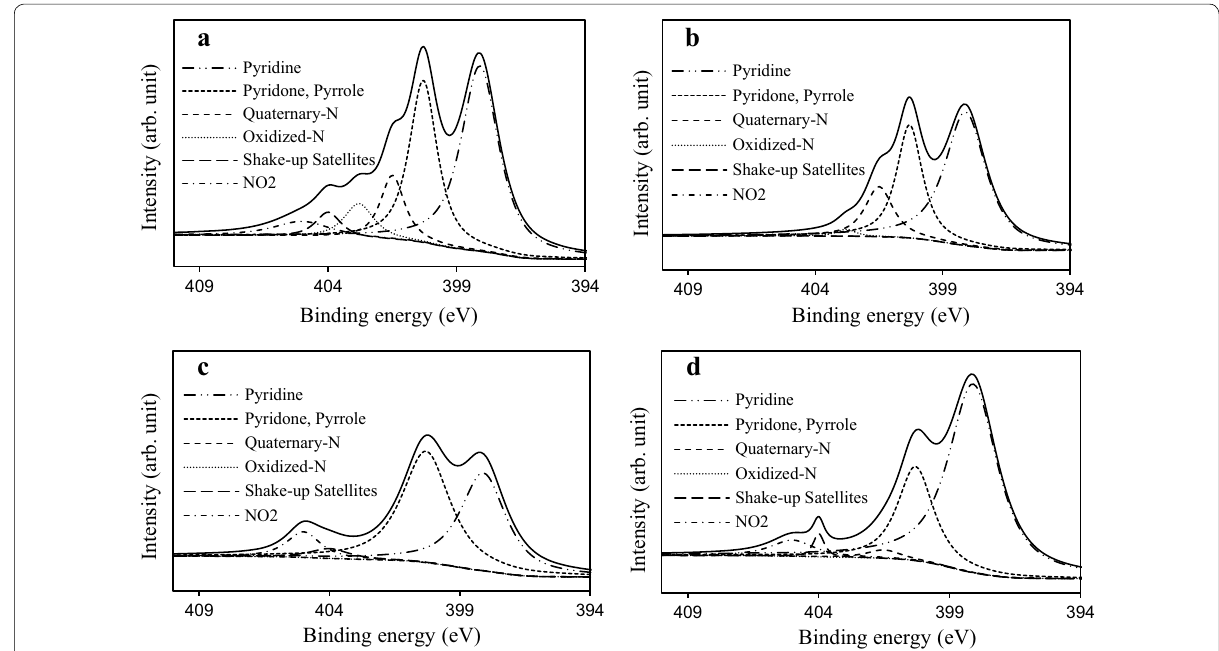
Fig. 6 The high resolution of deconvoluted XPS N 1s spectra of the ANF samples: a 60-ANF; b 60-ANF-TEPA; c 60-ANF-HNO 3 ; and d 60-ANF-HNO 3 -TEPA